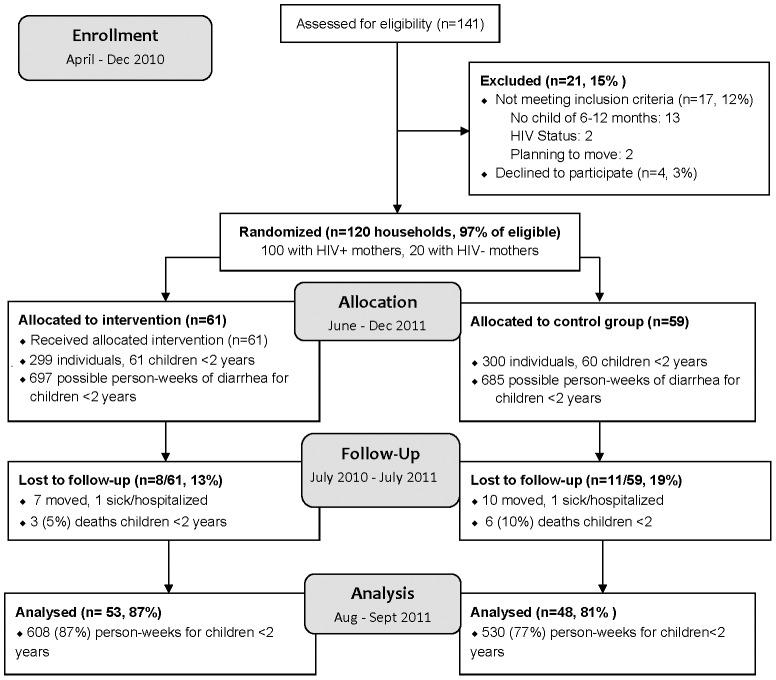
Recruitment flow diagram.